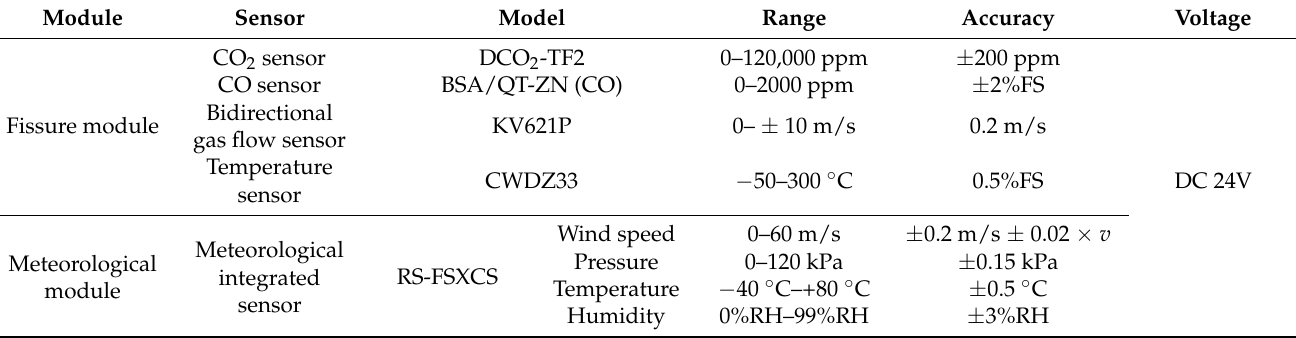
Table 1. Details of the sensors used in the proposed monitoring